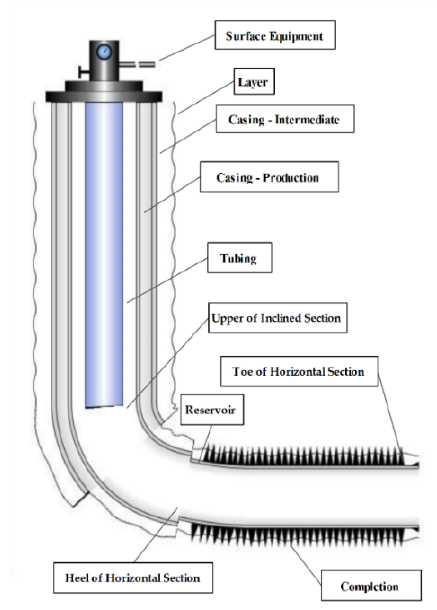
Figure 1. Conventional structure of horizontal gas well.